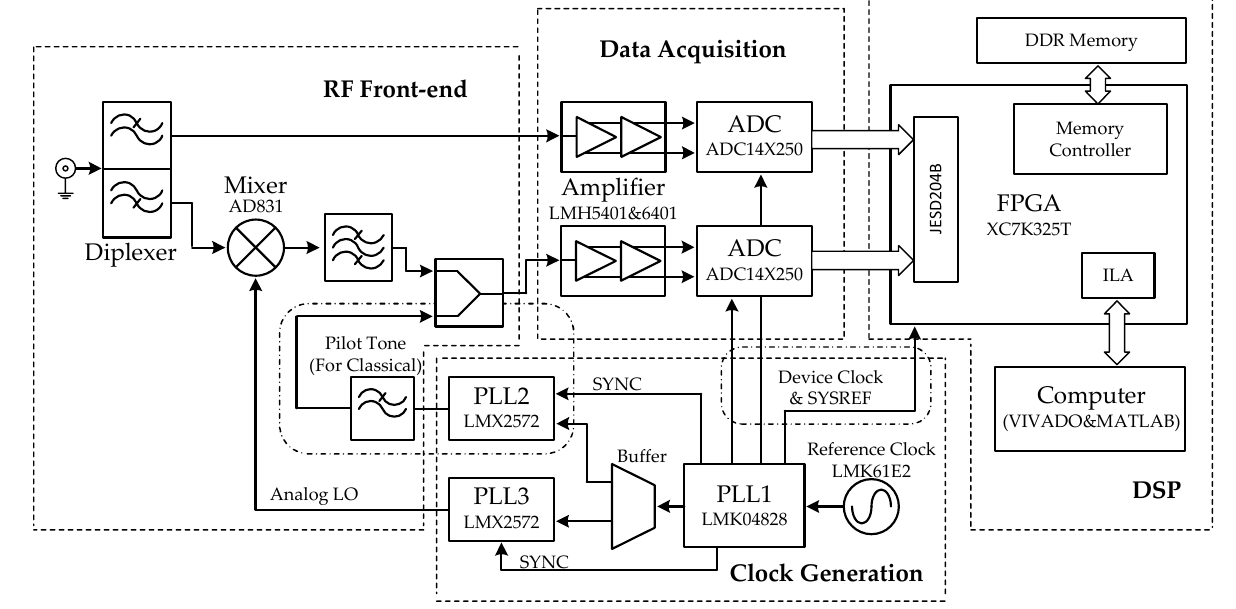
Figure 9. Block diagram of the evaluation